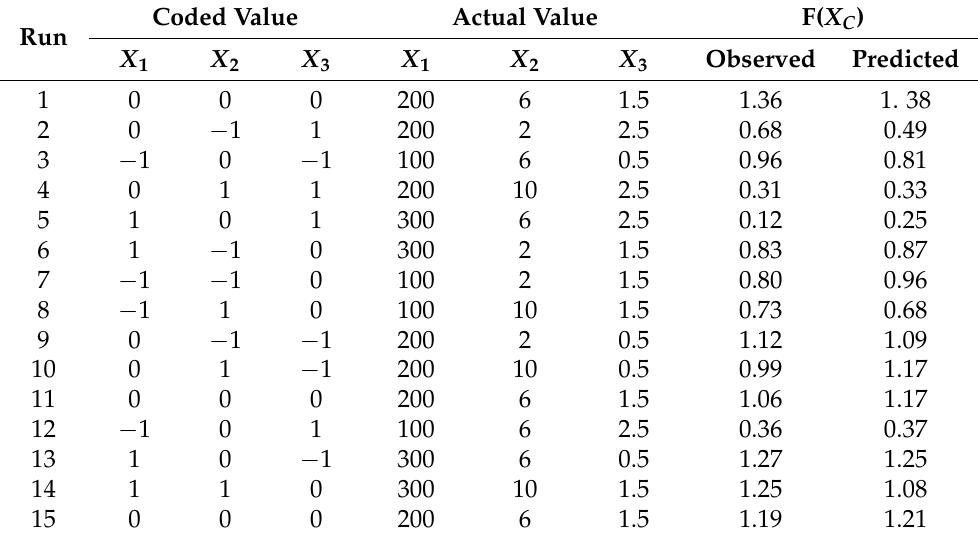
Table 2. Three-parameter BBD matrix with predicted and observed color response values (F( X C )).